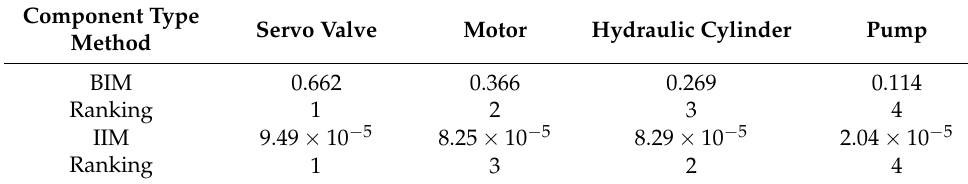
Table 3. BIM and IIM comparison at 5500